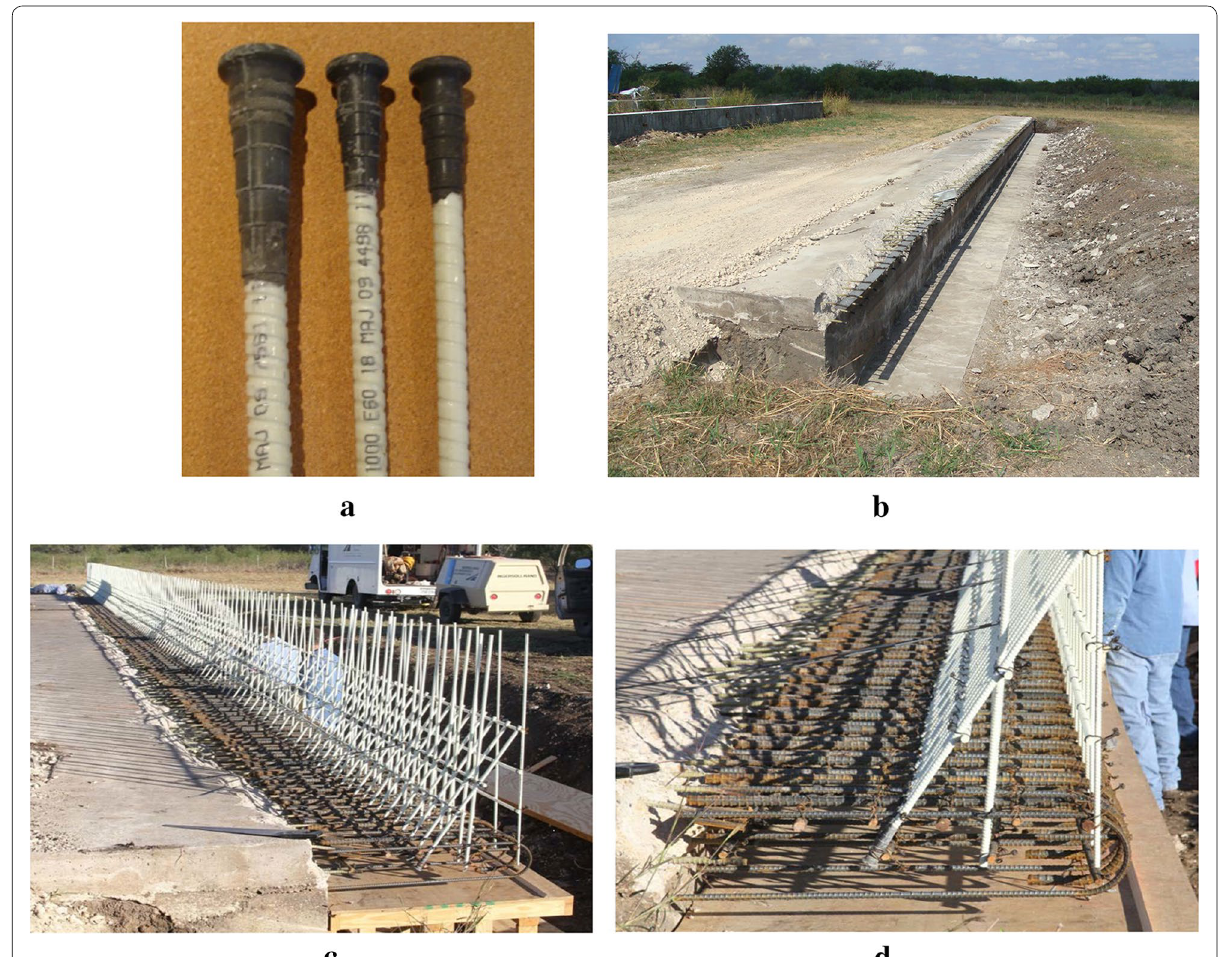
Fig. 3 Views of the GFRP bars, the constructed PL-3 barrier wall and supporting foundation. a GFRP bars with cast heads, b projecting steel dowels from existing foundation, c GFRP reinforcement, d deck cantilever